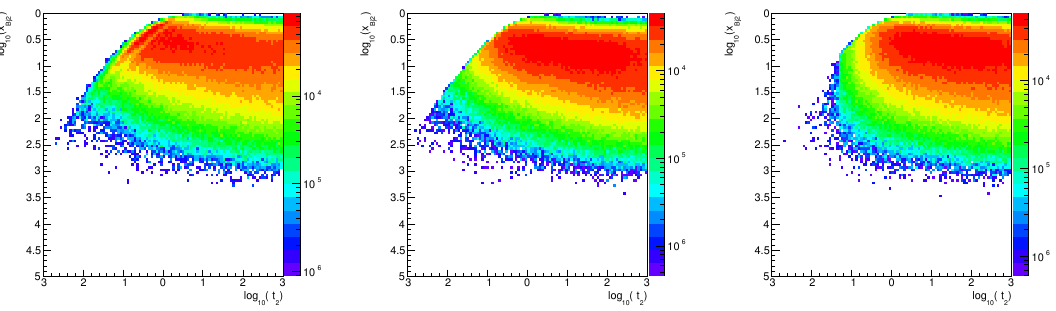
Figure 13 . Correlations in Q 2 p SU for s = 13 TeV.